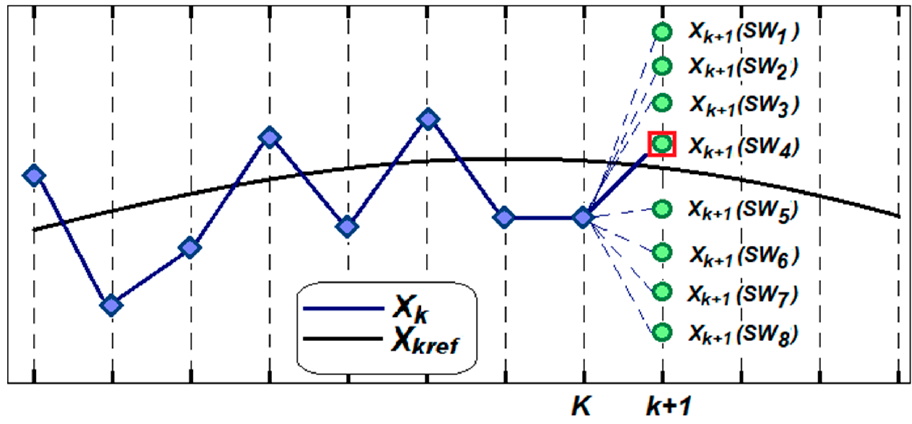
Figure 3. Predictive control principle of operation.